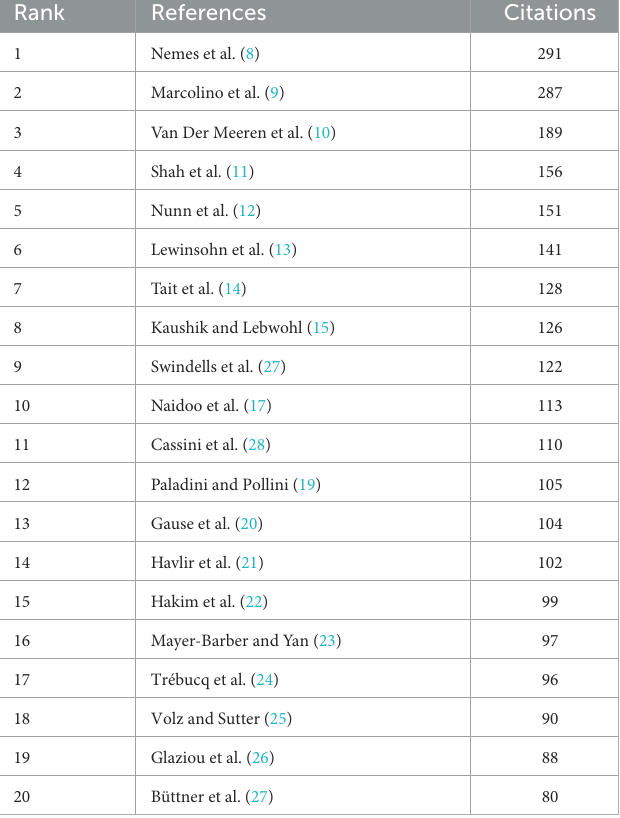
TABLE 4 The top 20 highly cited articles about HIV-MTB